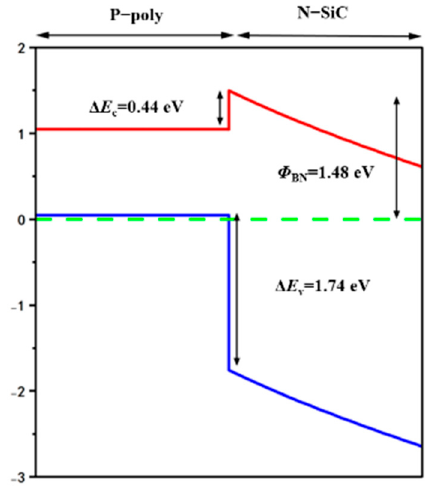
Figure 2. Band diagram of P-poly/N-SiC heterojunction diode. Table 1. Parameters of C-MOS and Proposed HJD-MOS.